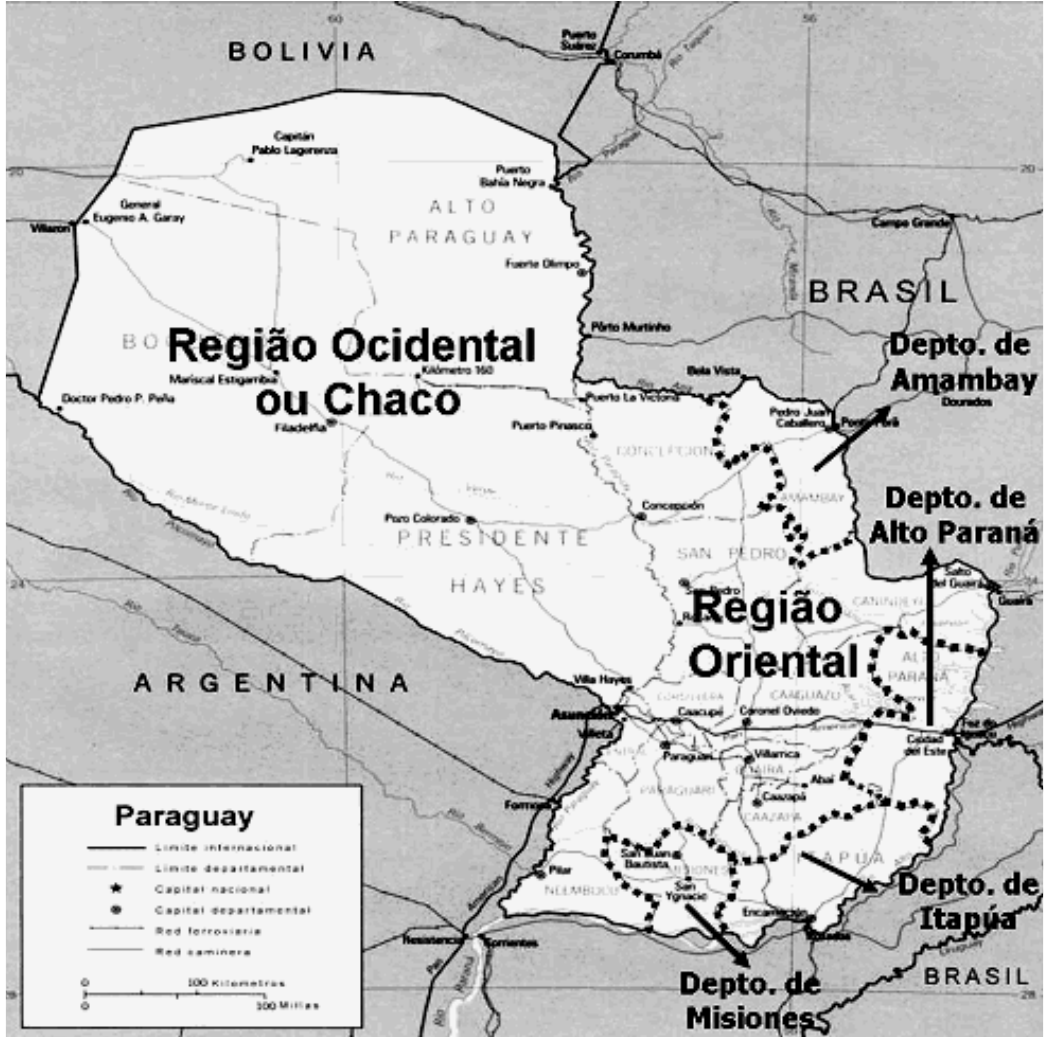
Figura 1. Mapa do Paraguai com os Departamentos onde foram realizados os experimentos de calibração (Departamentos de Misiones, Itapúa, Alto Paraná e